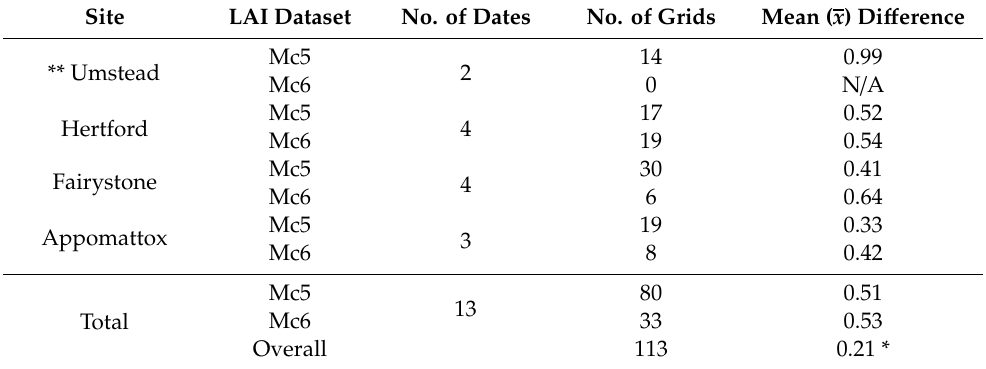
Table 8. 12.0 km grid-based mean di ff erences per LAI research site over all Mc5 and Mc6 data